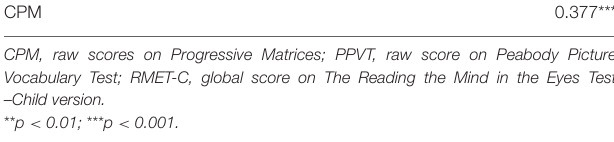
TABLE 2 | Partial correlations between RMET-C, CPM, and PPVT scores, controlling for children’s age. CPM PPVT RMET-C 0.408*** 0.258** CPM 0.377***